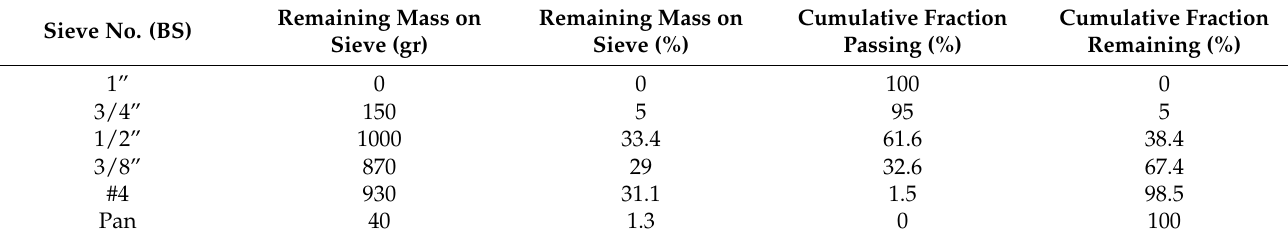
Table 2. Grading of coarse aggregates.